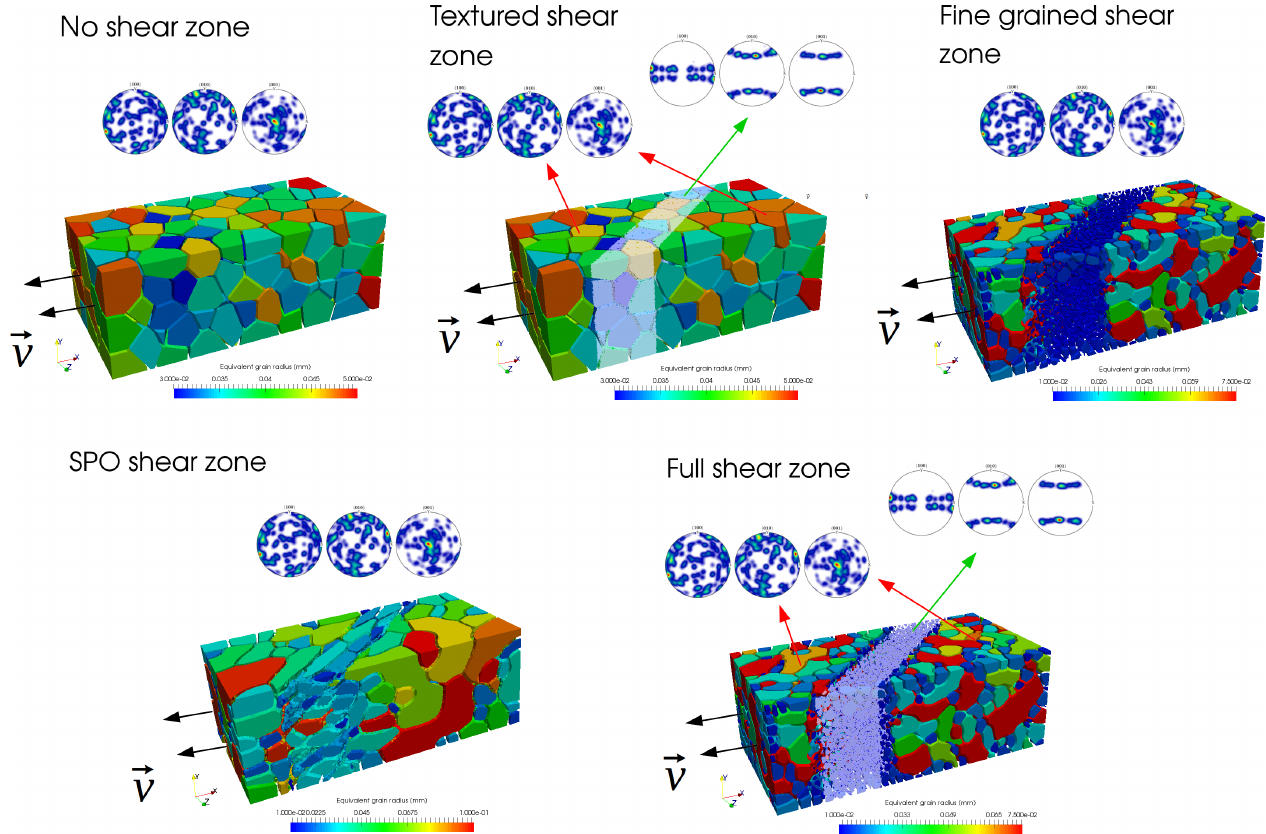
Figure 5. Initial setups of the performed simulations; color scale represents equivalent grain radius. Orientations within the different zones are represented through pole figures computed using MTEX (Mainprice et al., 2015).